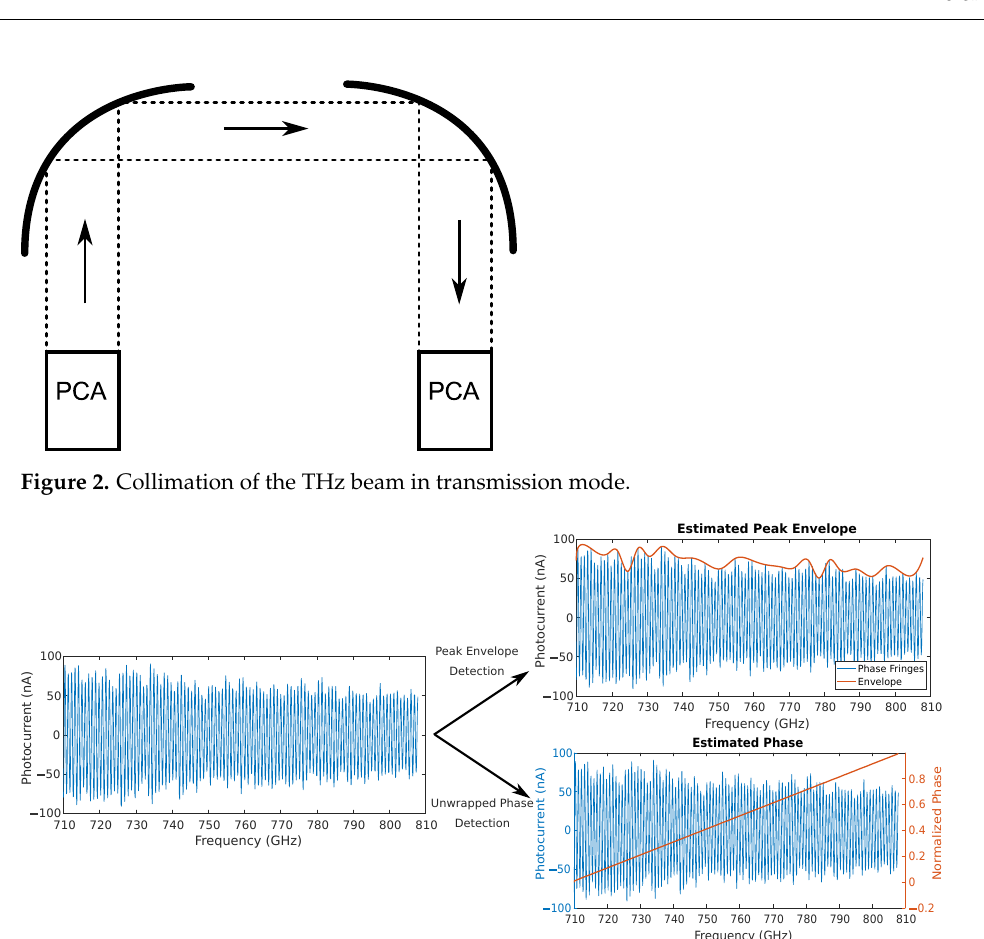
Figure 3. Peak envelope and unwrapped phase estimated from the detected phase fringes. The peak envelope represents the amplitude spectrum, and the unwrapped phase represents the phase